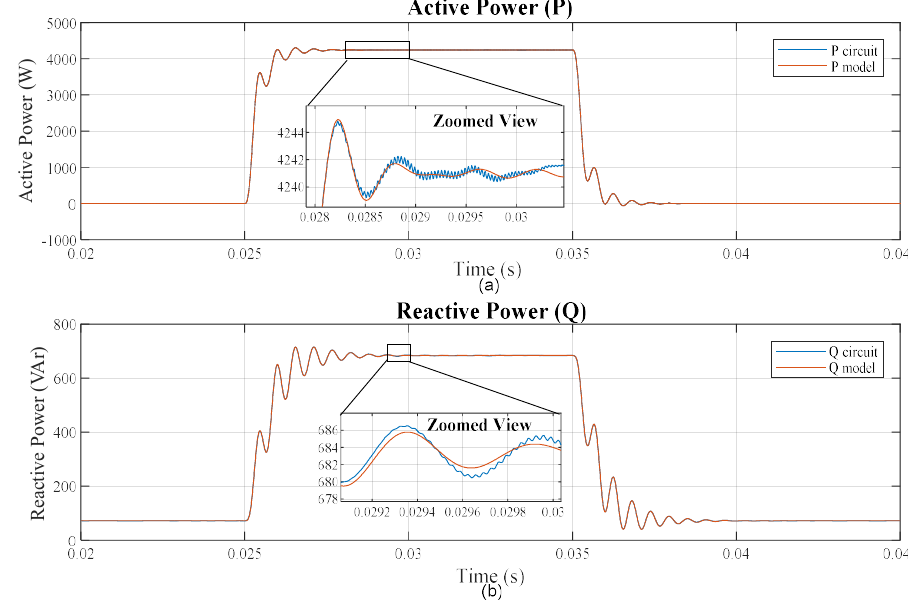
Figure 6. Power waveforms for the mathematical model and the circuit in grid-connected mode. ( a ) Active power; ( b ) reactive power.